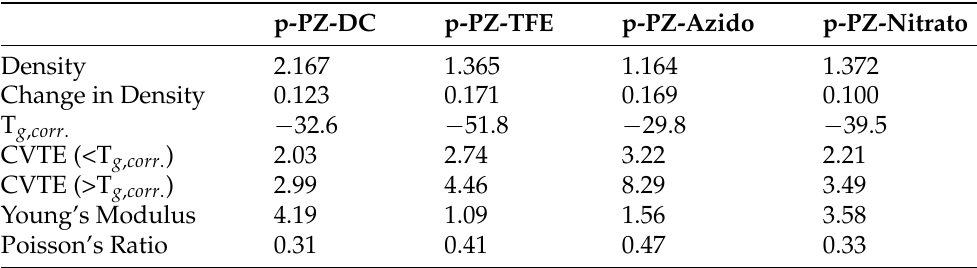
Table 2. Densities and thermo-mechanical properties of polymerised samples. Densities at 20 ◦ C in g · cm − 3 , T g , corr . in ◦ C and CVTEs in × 10 − 4 K − 1 , Young’s modulus in GPa, Poisson’s Ratio (in absolute numbers) unitless. p-PZ-DC